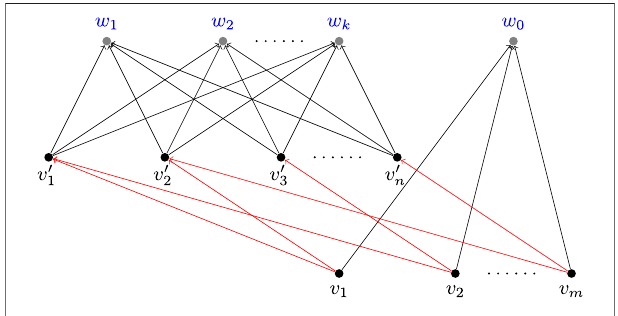
FIGURE3 | An exampleof the reduction, where the edge with activation probability 1 is in red and the other edges have probability c.